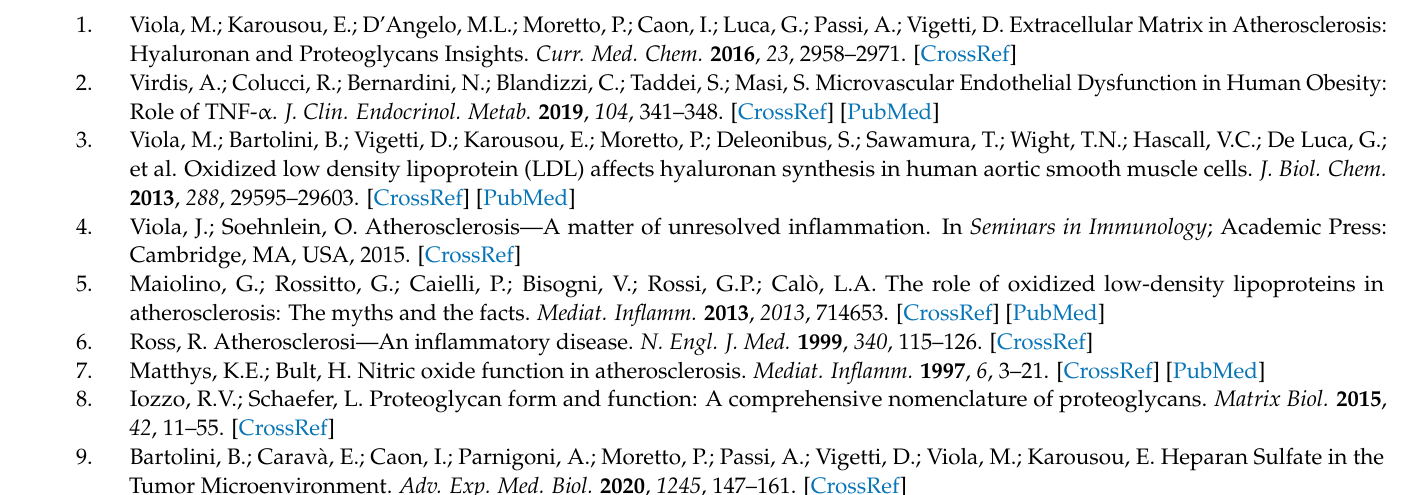
Figure S3: Expression levels of Syndecan chains biosynthetic enzymes. Figure S4: GAGs